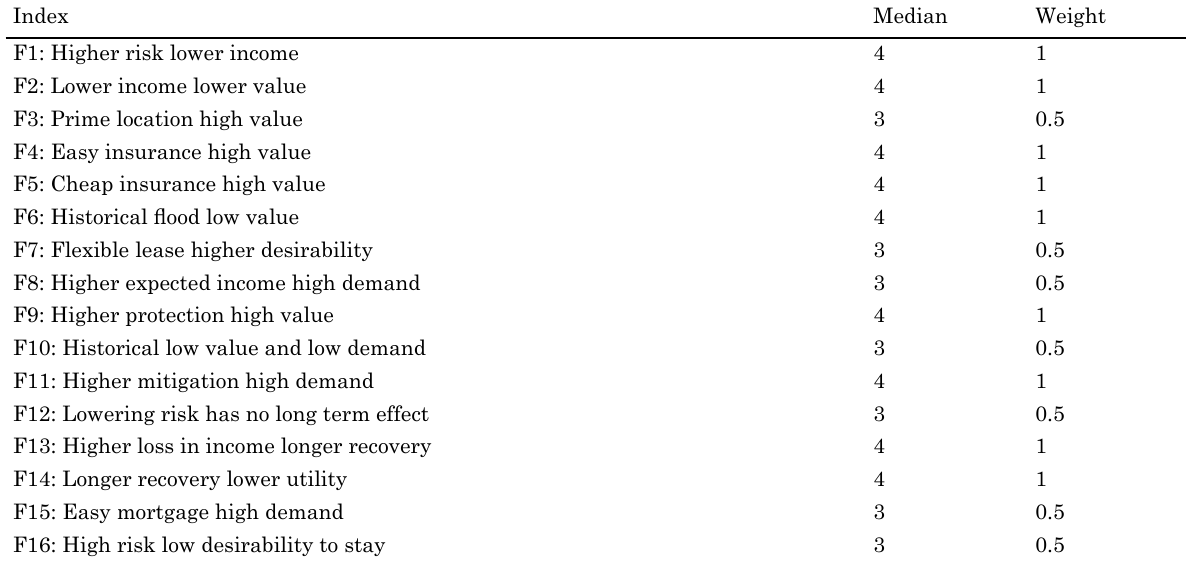
Table 1. Vulnerability summary table (VsT) illustrating weights associated with